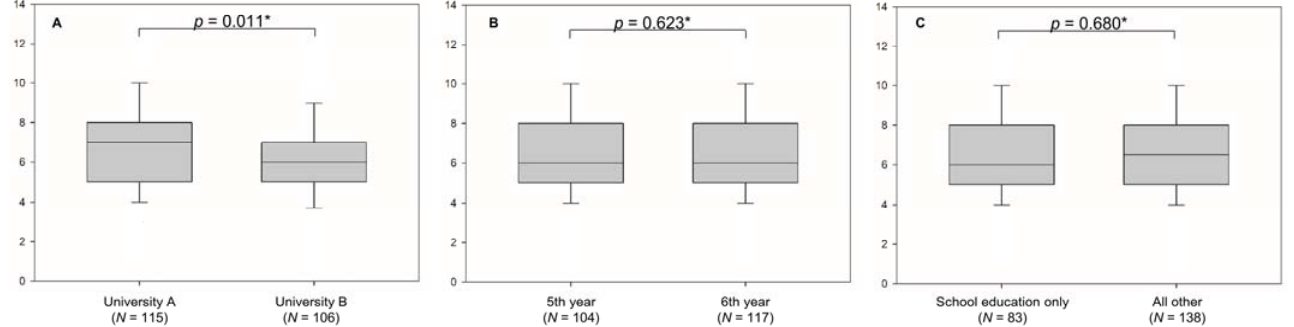
Figure 1. Students’ knowledge score about gout and asymptomatic hyperuricemia relative to university ( A ), study year ( B ), and source of education ( C ). * Mann–Whitney U test.